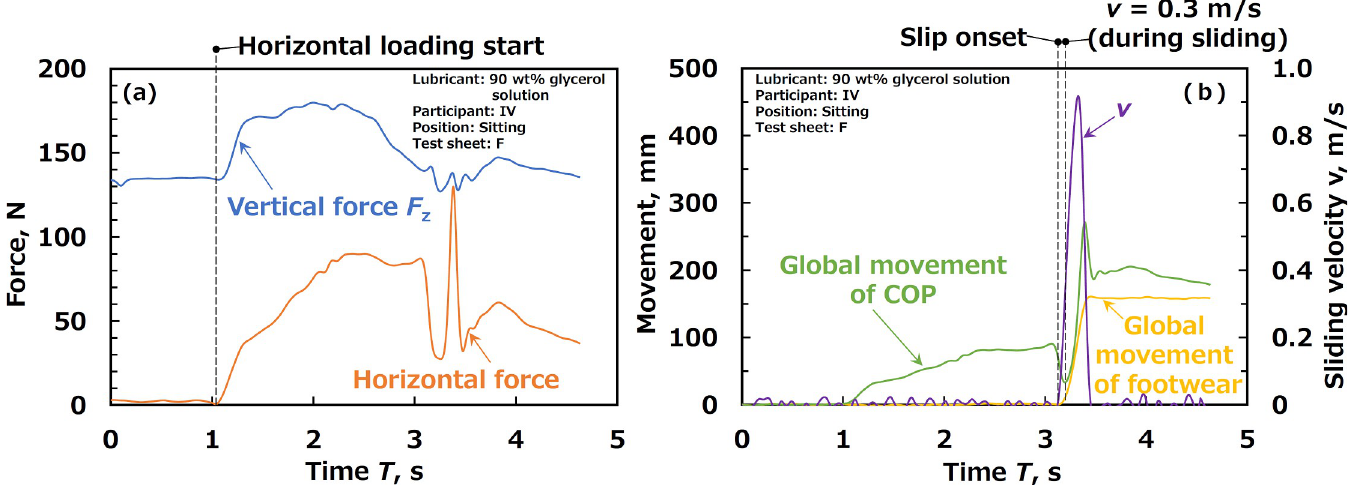
Fig 5. Examples of data obtained from force plate and laser rangefinder regarding (a) forces and (b) movements and velocity.